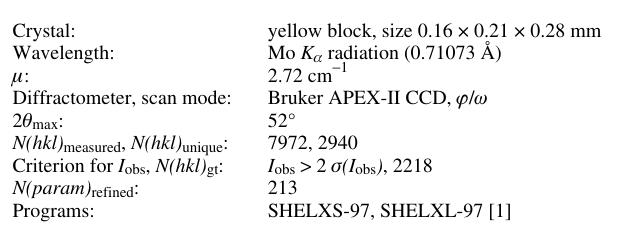
Table 1. Data collection and handling.